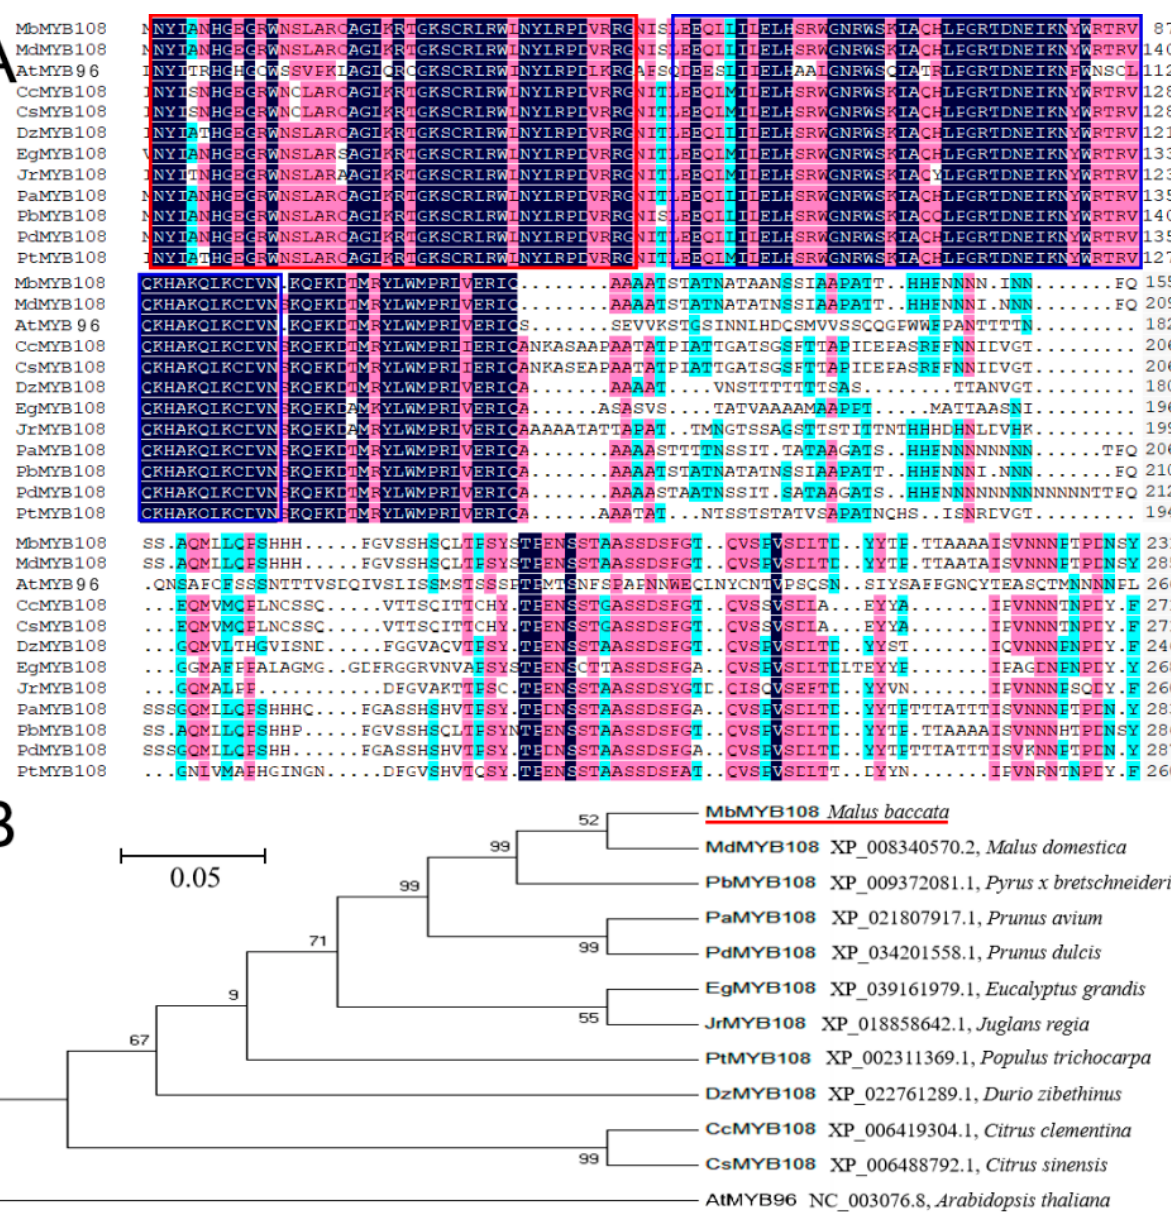
Figure 1. Comparison and phylogenetic relationship of MbMYB108 with other species of MYB transcription factor (TF) proteins. ( A ) Amino acid sequence alignment of MbMYB108 with other species of MYB TF proteins. Conserved domains are shown in red and blue boxes. ( B ) Phylogenetic tree analysis of MbMYB108 and other species of MYB TF proteins.